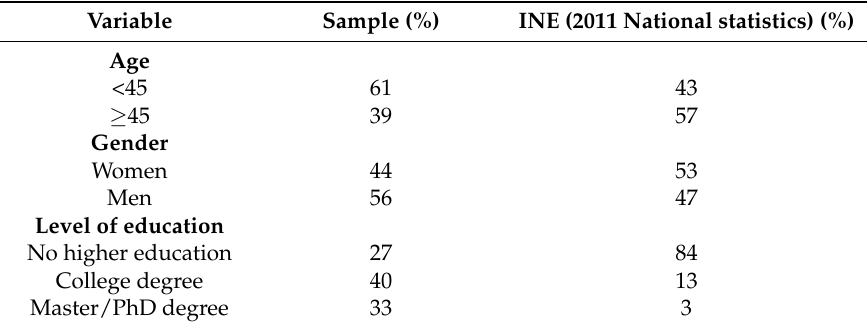
Table 4. Demographics of